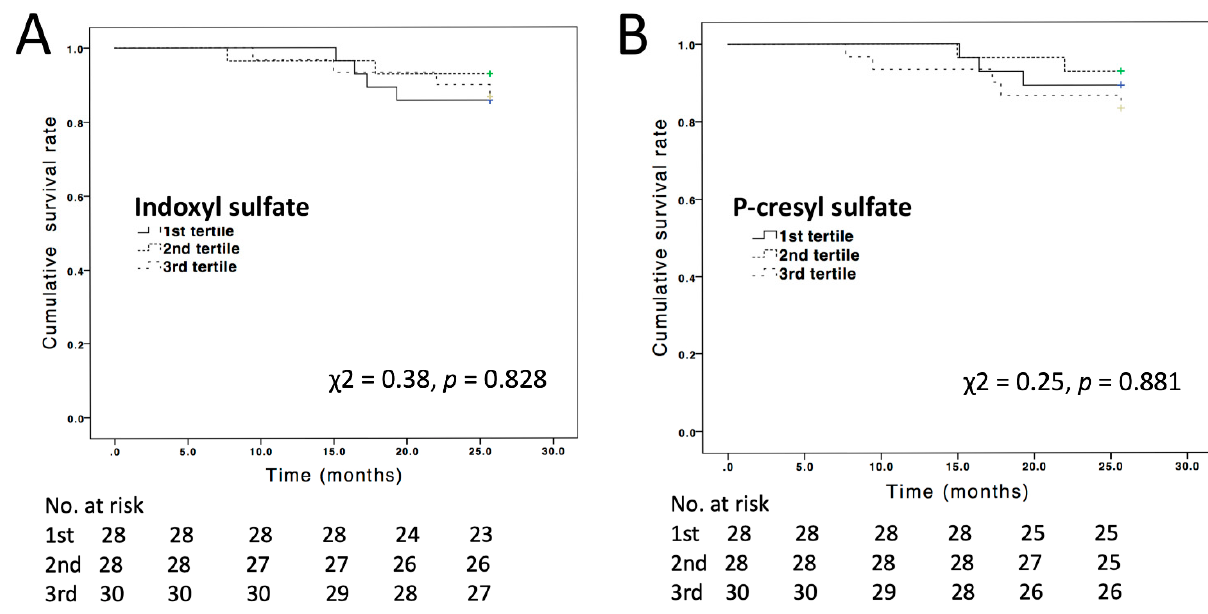
Figure 4. Kaplan–Meyer analysis of associations of serum levels of ( A ) indoxyl sulfate and ( B ) P-cresyl sylfate with survival.